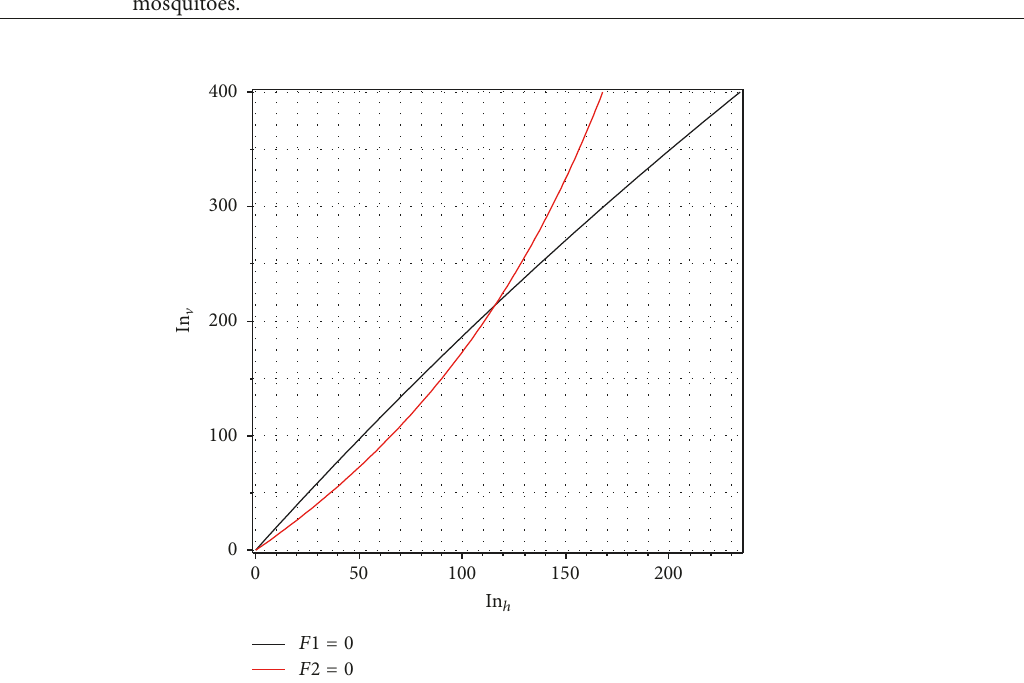
Figure 2: Existence of endemic equilibrium for In V and In ℎ depending on couple of polynomial